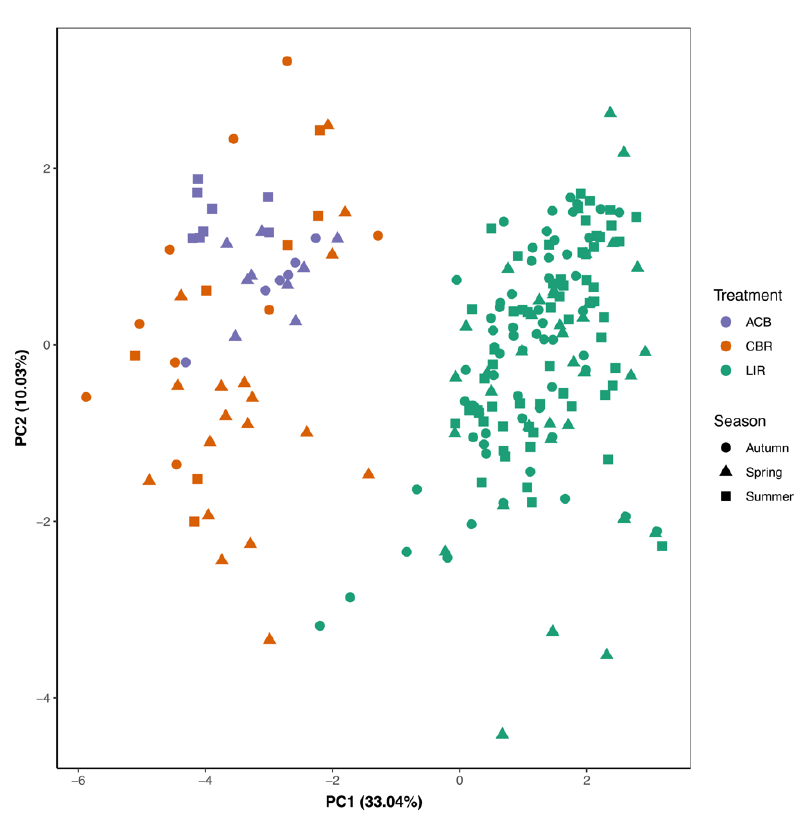
Figure 2. PCA of local habitat transect data (BASS) from 2015–2017, coded by treatment (color) and season (shape) [21,22]. Table 1. Loading values for each original variable on the first two principal components after PCA analysis of the local-scale habitat data from all three treatments across all three years.